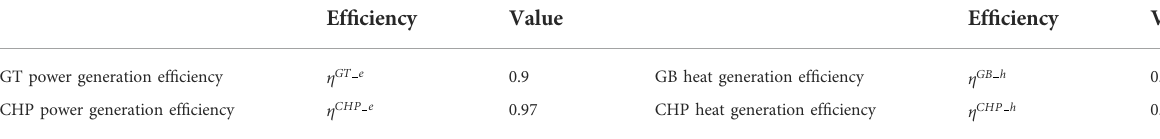
TABLE 4 Ef fi ciencies of equipment in the RIES.